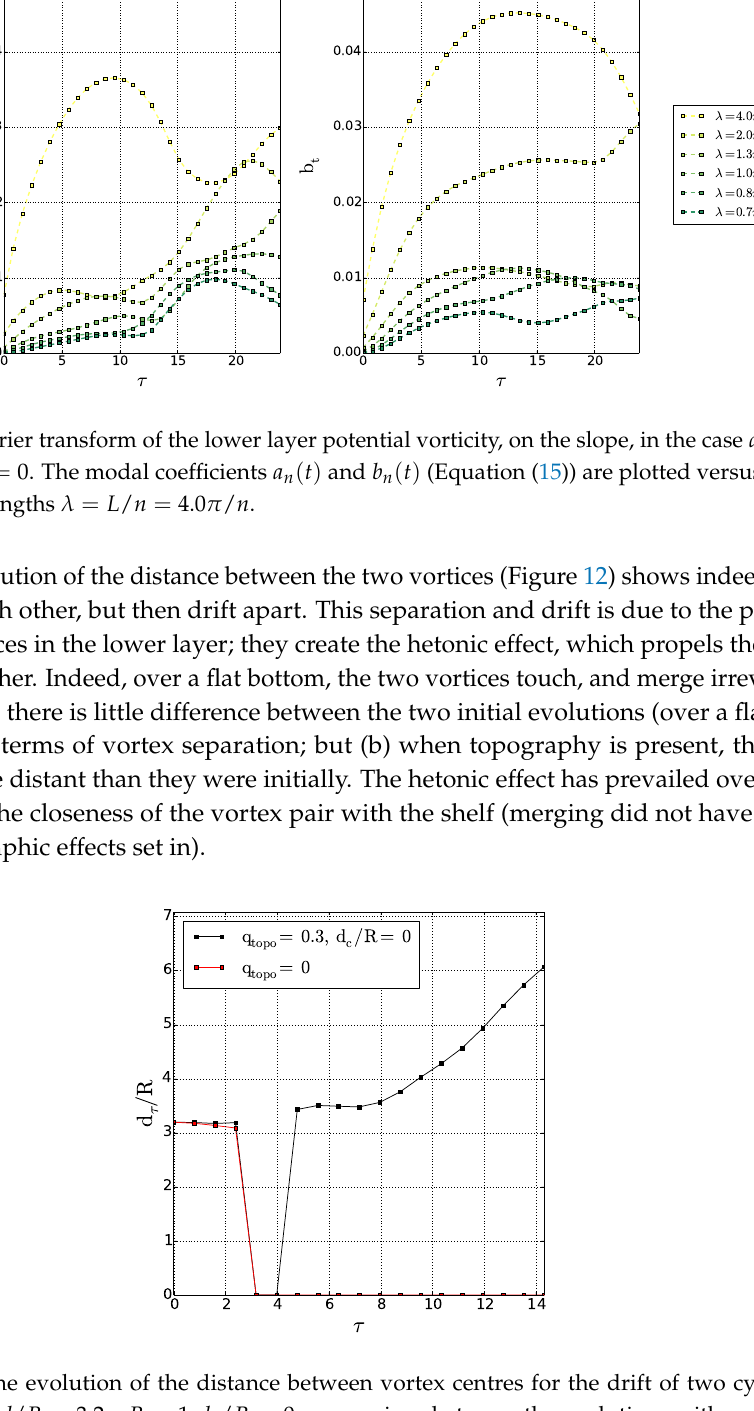
Figure 12. Time evolution of the distance between vortex centres for the drift of two cyclones on the shelf; case d / R = 3.2, γ R = 1, d c / R = 0; comparison between the evolutions with and without the